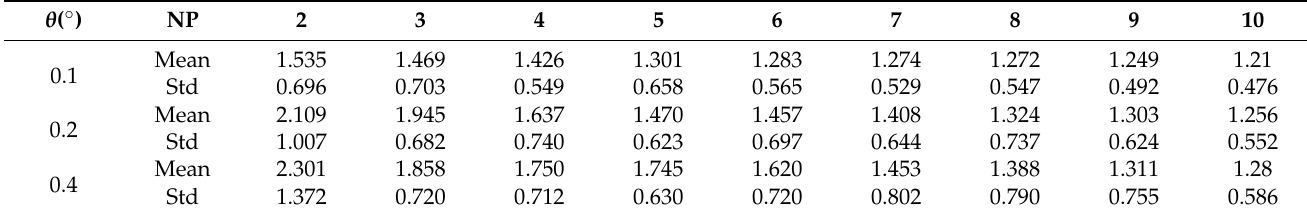
Table 5. Mean and standard deviation of re-projection errors for 2–10 groups of images and point clouds.